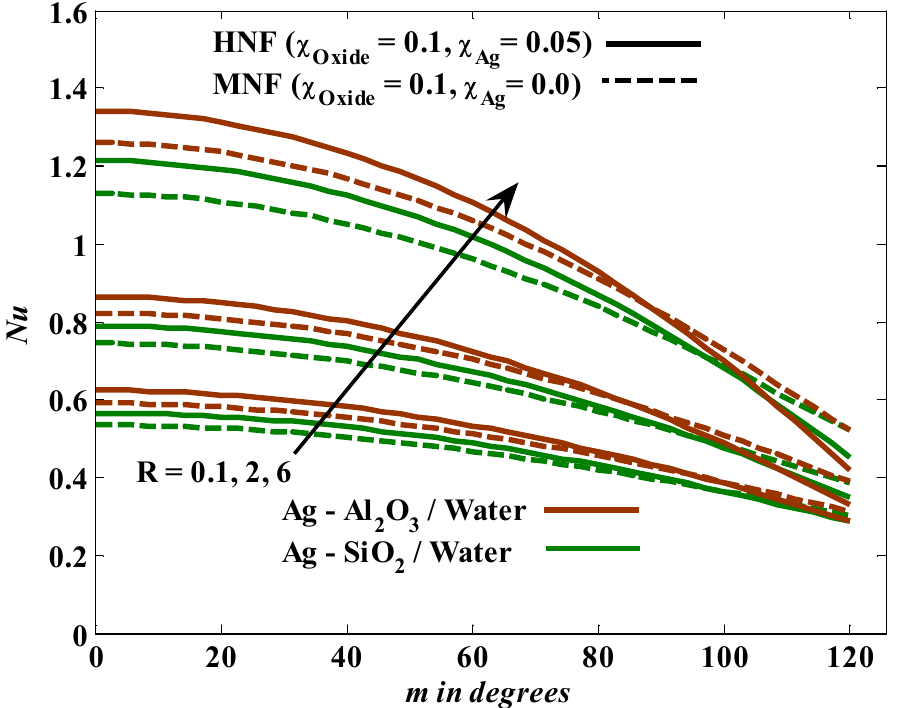
Figure 4. Illustration of R versus Nusselt number at fixed values of We = 0.2, λ = 0.1, & M =